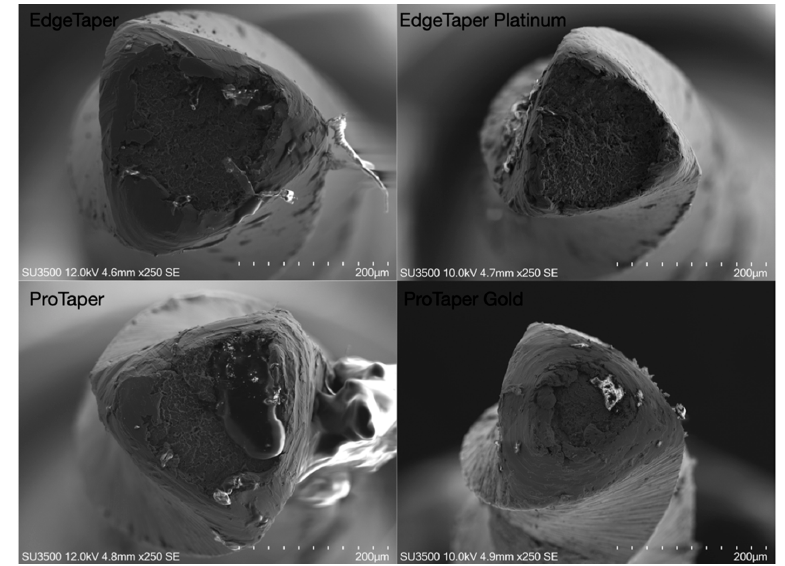
Figure 4. SEM analysis. Flexural fracture evidenced by the fatigue striations.